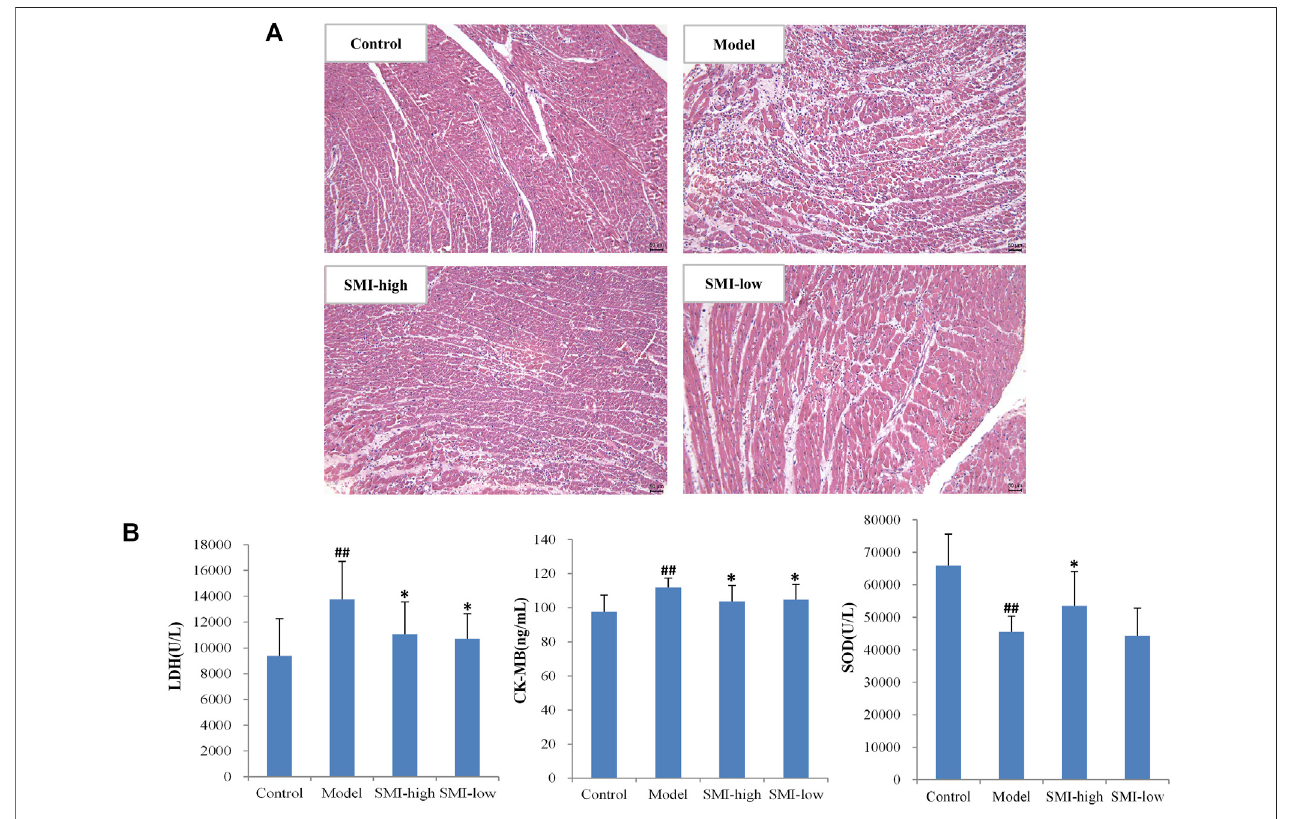
FIGURE 2 | Cardioprotective effect of SMI on ISO-induced myocardial ischemia injury in rats. (A) Representative H&E images (200 × ) of myocardial histology analysisforcontrol,model,SMI-high,andSMI-low grouprats. (B) SerumLDH,CK-MB,and SODlevelsincontrol,model, SMI-high,and SMI-lowgrouprats.(Datawere expressed as Mean ± SD ( n (cid:1) 10), ## p < 0.01 vs. control, * p < 0.05 vs. model).